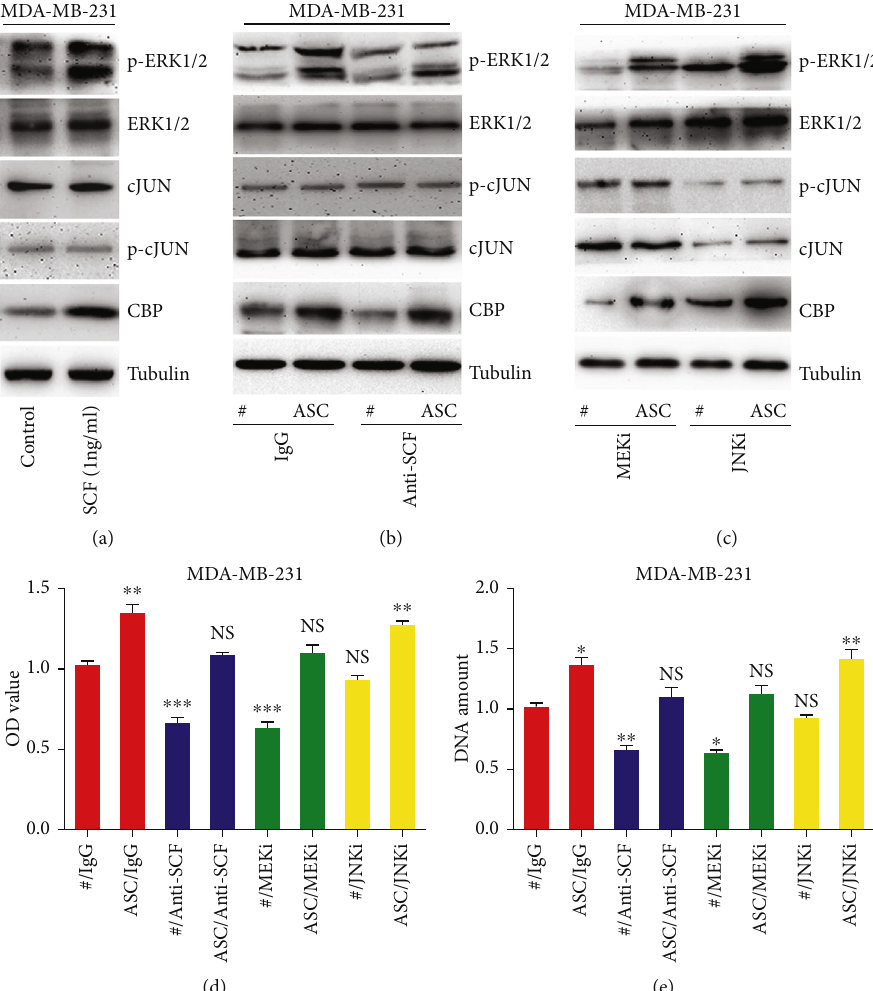
Figure 2: The e ff ects of ASCs on MDA-MB-231 breast cancer cells are mediated by MEK-ERK-CBP signaling. (a) Western blot analysis of the association between MAPK pathways and CBP in MDA-MB-231 cells treated with ASC culture supernatant. (b – c) The indicated proteins in MDA-MB-231 cells induced by ASCs and the cell viability (d) and proliferation (e) were analyzed. The cells were pretreated with IgG- or anti-SCF-neutralizing antibody for 1 h, 1 μ M selumetinib (MEKi), and 10 μ M SP600125 (JNKi) for 24 hours. The results were normalized; the cells that were treated with IgG were used as a positive control; and the value was set to 1. ∗ P < 0 : 05 , ∗∗ P < 0 : 01